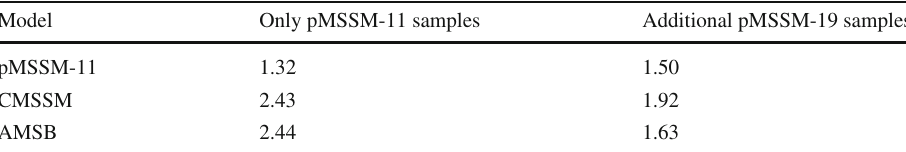
Table 6 Performance of the 13 TeV neural network in the reparametrized approach applied to models different from the pMSSM-11 used for training